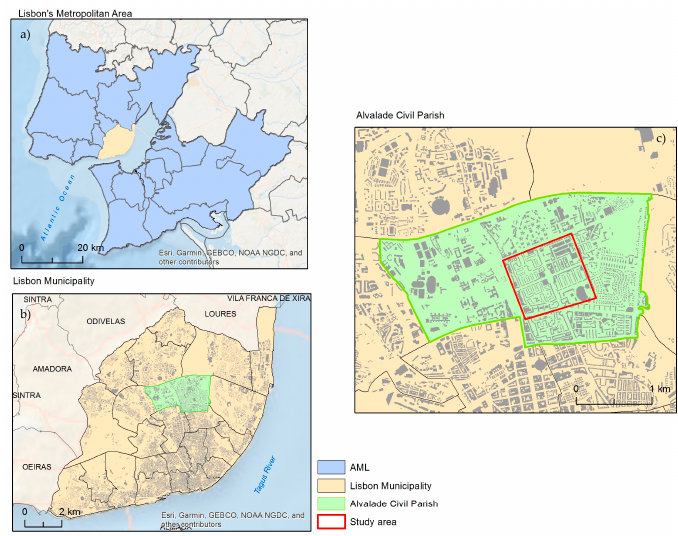
Figure 2. Study area framing map. AML = Lisbon Metropolitan Area (a).